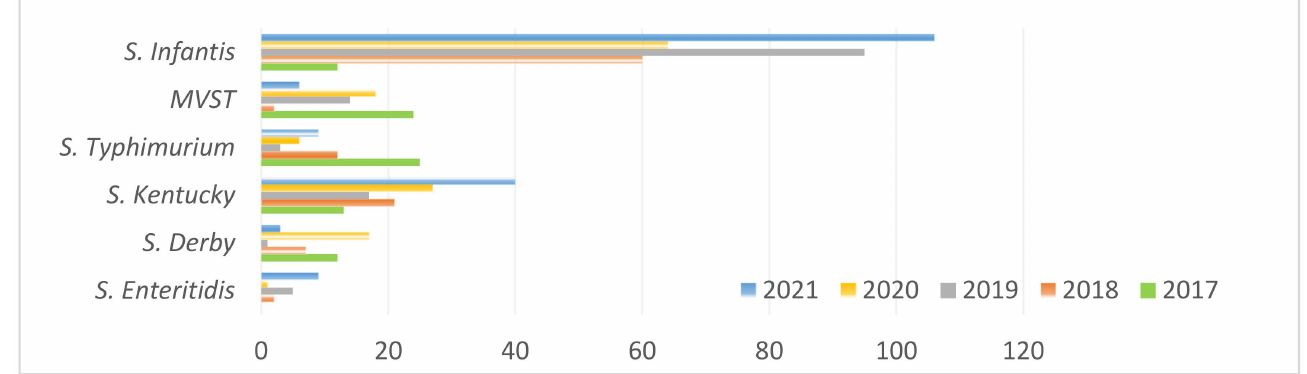
Figure 1. Distribution of S. Infantis, MVST, S. Typhimurium, S. Kentucky, S. Derby and S . Enteritidis per year. FA